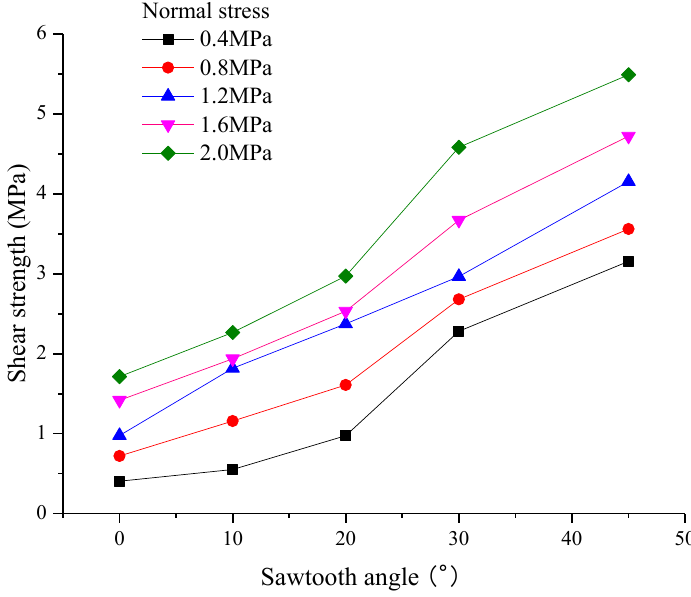
Figure 7. Relationship between shear strength and sawtooth angle.